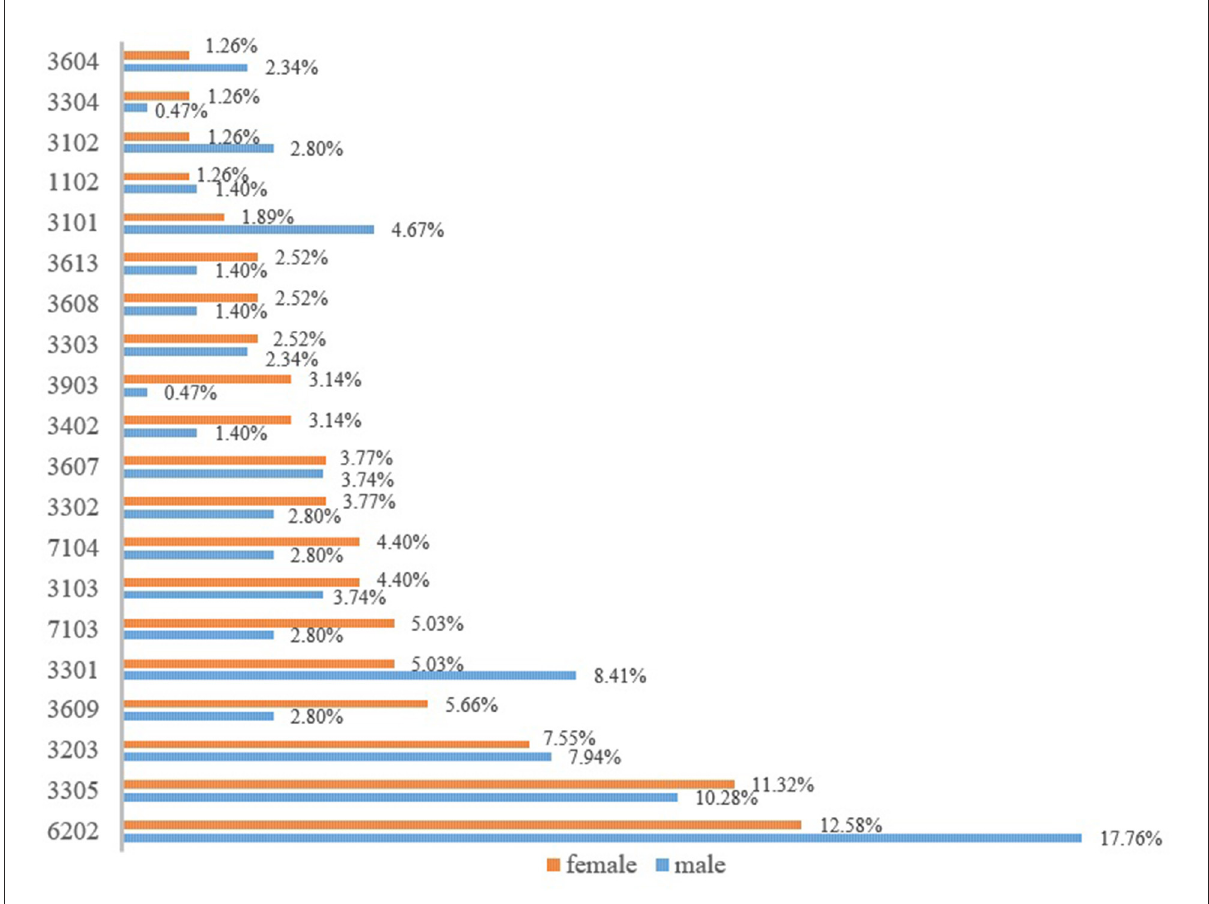
FIGURE2 Major medical errors among older patients according to